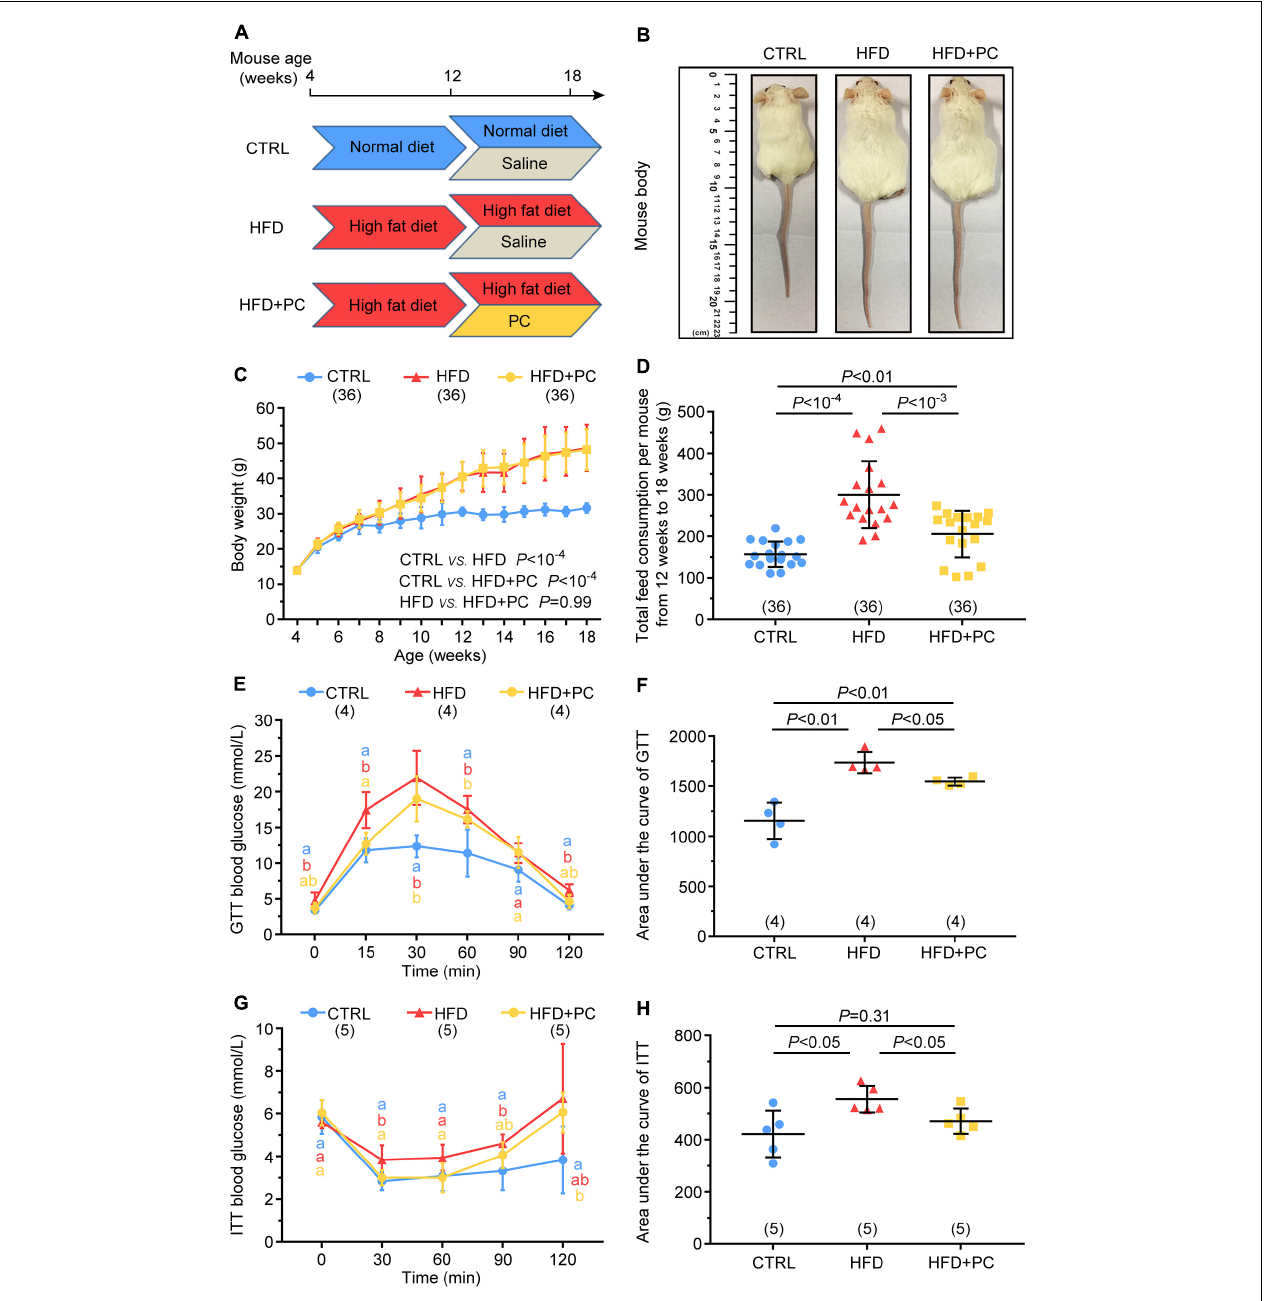
FIGURE 1 | PC improved glucose tolerance and insulin resistance in obese female mice. (A) Experimental design. The mice in the CTRL group were fed a normal diet (blue) and had intragastric administrations of saline (gray). Mice in the HFD group were fed a high-fat diet (red) and had intragastric administrations of saline (gray). The mice in the HFD + PC group were fed a high-fat diet (red) and had intragastric administrations of PC (yellow). (B) Image of mice at the age of 18 weeks. (C) Weight changes in mice (4–18 weeks of age). (D) Average food consumption (12–18 weeks of age). (E) Blood glucose changes in GTT. (F) GTT AUC values. (G) Blood glucose changes in ITT. (H) ITT AUC values. Data are expressed as mean ± SD and were compared by one-way ANOVA and Newman–Keuls post hoc tests. In (E,G) , the different letters at the same time point near the error bars indicate statistical significance ( p < 0.05). The number of mice in each group is shown in